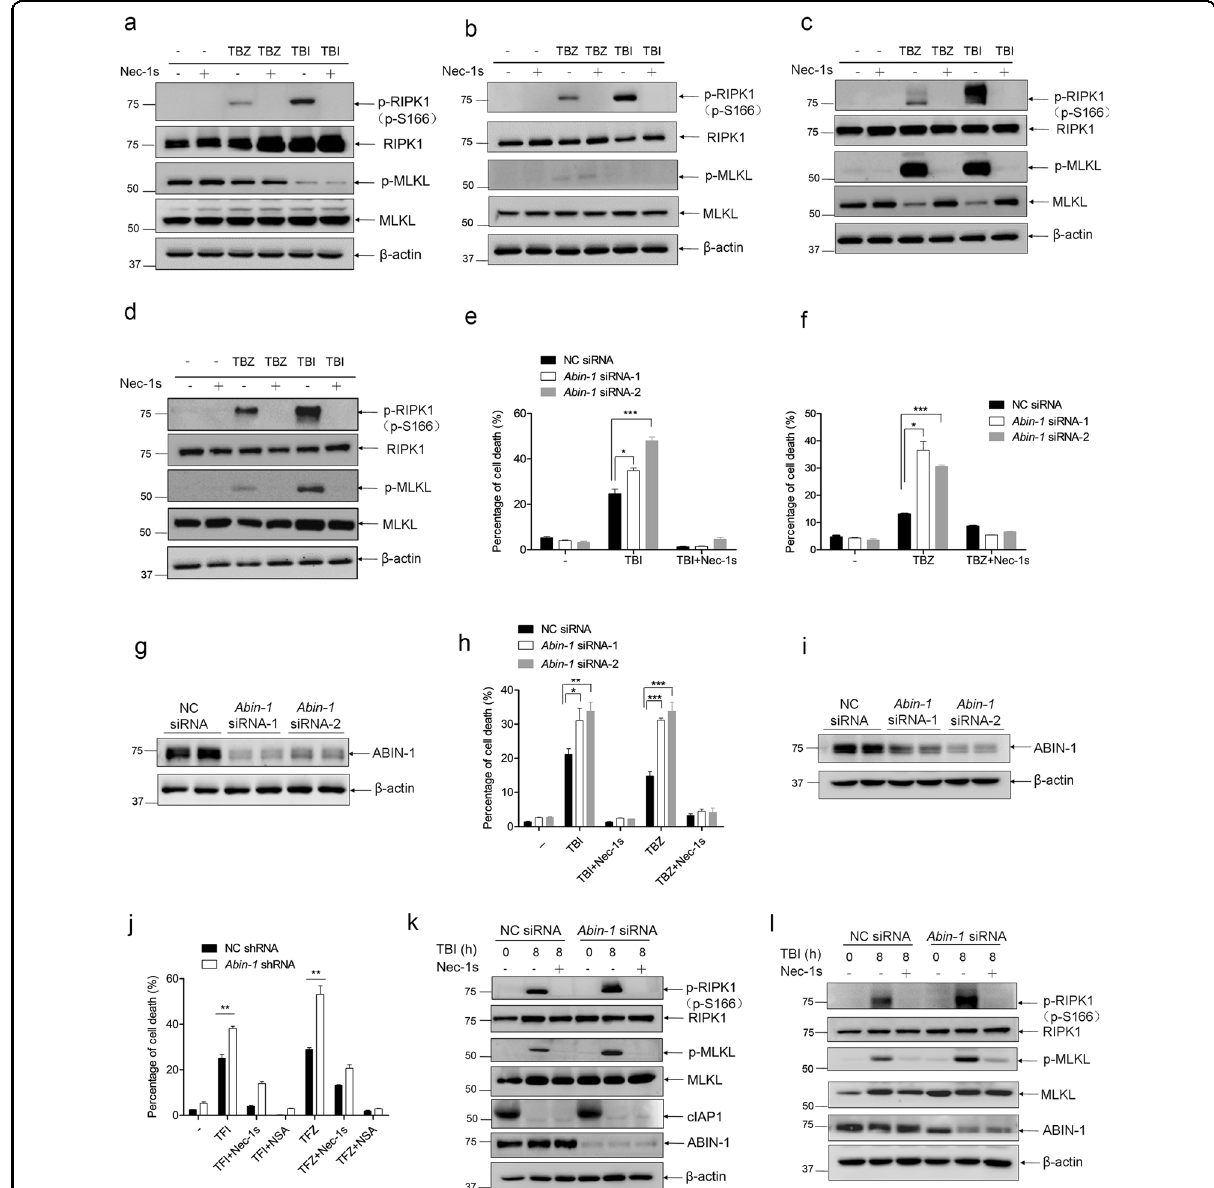
Fig. 3 ABIN-1 de fi ciency sensitizes colorectal cancer cells to TNF + birinapant + zVAD/IDN-6656- and TNF + 5- fl uorouracil + zVAD/IDN-6556- induced necroptosis. a – d Four different human CRC cell lines were treated with TNF + birinapant + zVAD (TBZ) or TNF α + birinapant + IDN-6556 (TBI) for 8h in the presence or absence of Nec-1s. Cells were lysed by RIPA buffer at 8h and necroptosis markers phospho-RIPK1 (p-RIPK1), RIPK1, phospho-MLKL (p-MLKL), and MLKL were detected by western blot. TNF, 10ng/ml; birinapant, 100nM; zVAD, 20 μ M; Nec-1s, 10 μ M; and IDN-6556, 2.5 μ M. Caco-2, human colorectal adenocarcinoma cell ( a ); HCT116, human colorectal carcinoma cell line ( b ); HT-29, human colorectal adenocarcinoma cells ( c ); and COLO205, human colorectal adenocarcinoma cells ( d ). e – g HT-29 cells were transfected with two different Abin-1 siRNAs and incubated for 24h. Then, cells were re-plated and treated with TNF + birinapant + IDN-6556 (TBI) or TNF + birinapant + zVAD (TBZ) for 8h in the presence or absence of Nec-1s. Cell deaths were measured by ToxiLight assay. TBI treatments + / − Nec-1s ( e ); TBZ treatments + / − Nec-1s ( f ); and Knockdown ef fi ciency in HT-29 cells ( g ). Proteins were extracted from HT-29 cells 32h after siRNAs transfection. Each siRNA sample was loaded in duplicates. h – i COLO205 cells were transfected with two different Abin-1 siRNAs and incubated for 24h. Then, cells were re-plated and treated with TBI or TBZ for 8h in the presence or absence of Nec-1s. Cell deaths were measured by ToxiLight assay ( h ); knockdown ef fi ciency ( i ). j HT-29 cells were transduced with lentivirus-based control shRNA or Abin-1 shRNA and screened with puromycin for 5 days. Then, cells were treated with TNF + 5- fl uorouracil + IDN-6556 (TFI) or TNF + 5- fl uorouracil + zVAD (TFZ) for 36h in the presence or absence of Nec-1s or necrosulfonamide (NSA). k , l HT-29 cells or COLO205 cells were transfected with control siRNA or Abin-1 siRNA and incubated for 24h. Then, cells were re- plated and treated with TBI for 8h in the presence or absence of Nec-1s. Cell lyses were subjected to western blot and p-RIPK1, RIPK1, p-MLKL, MLKL, cIAP1, and ABIN-1 were detected. Cell deaths were measured by ToxiLight assay. HT-29 cells TBI treatments + / − Nec-1s (k) ; and COLO205 cells TBI treatments + / − Nec-1s ( l ). TNF α , 10ng/ml; birinapant, 100nM; zVAD, 20 μ M; Nec-1s, 10 μ M; IDN-6556, 2.5 μ M; NSA, 5 μ M; and 5-FU, 250 μ M. * P <0.05, ** P <0.01, or *** P